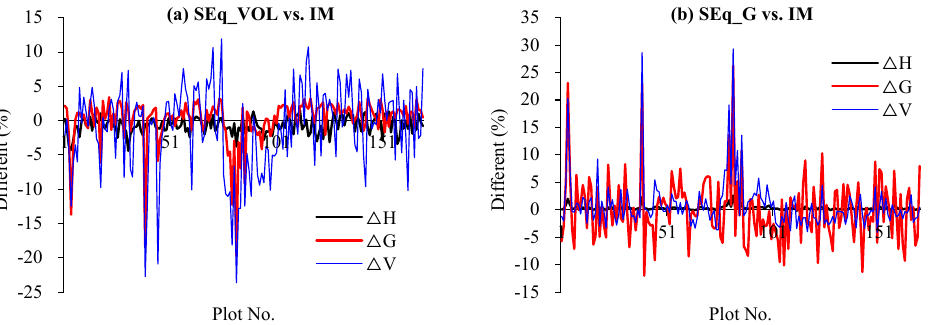
Figure 3. The plot-level differences of the estimates of H, G, and V between the SEqs and the IMs of the pine forests: ( a ) H and G were used as the endogenous variables to estimate V; ( b ) H and V were used as the endogenous variables to estimate G.